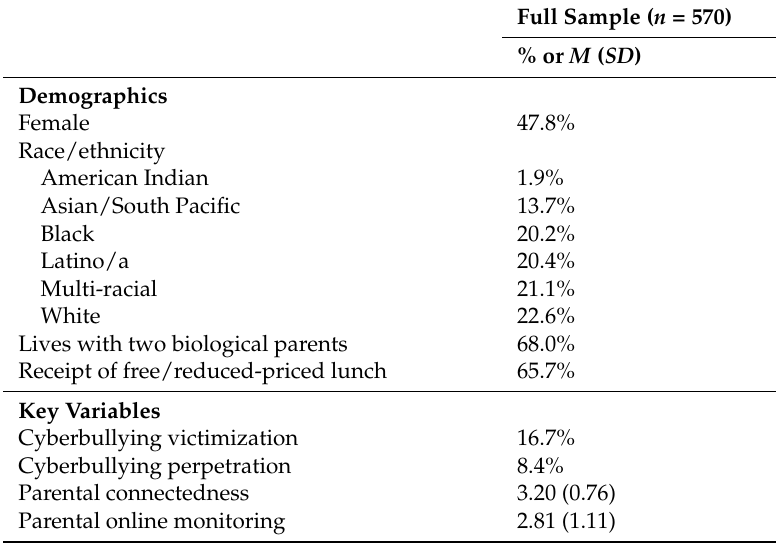
Table 1. Descriptive statistics of the sixth grade sample: youth report of key